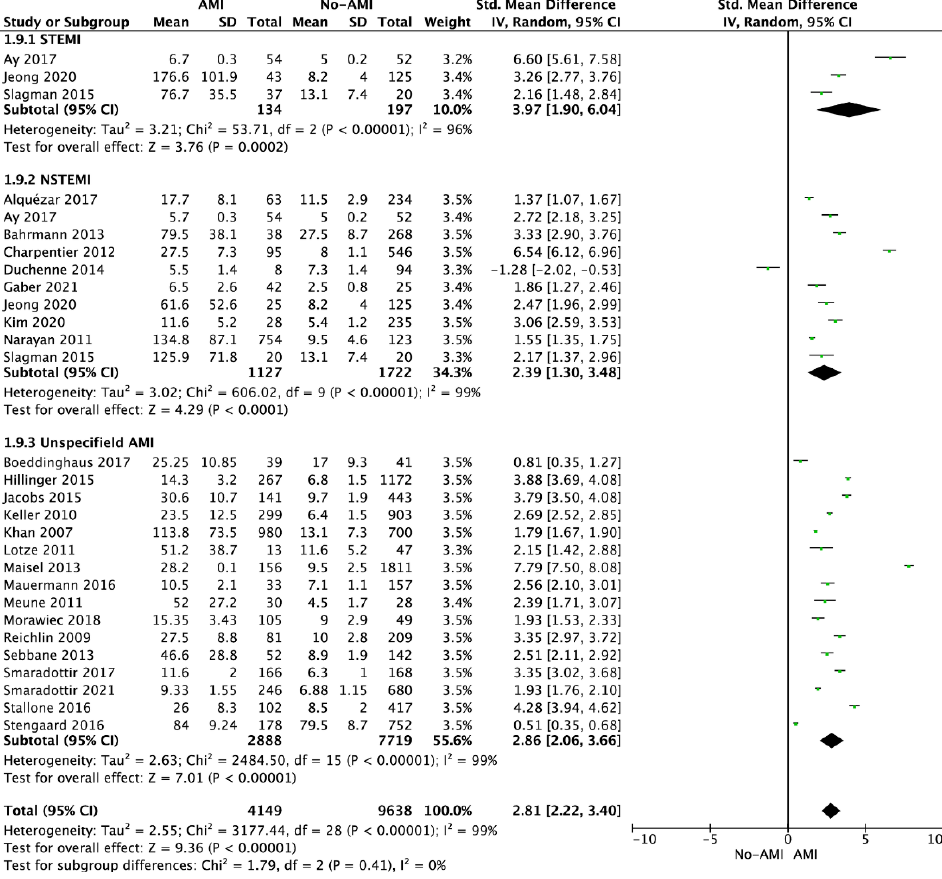
Figure 2. Forest plot of copeptin levels in the AMI and no-AMI groups. The center of each square represents the weighted standard mean difference for individual trials, and the corresponding horizontal line stands for a 95% confidence interval. The diamonds represent pooled results. Legend: CI = confidence interval; SMD = standard mean difference.